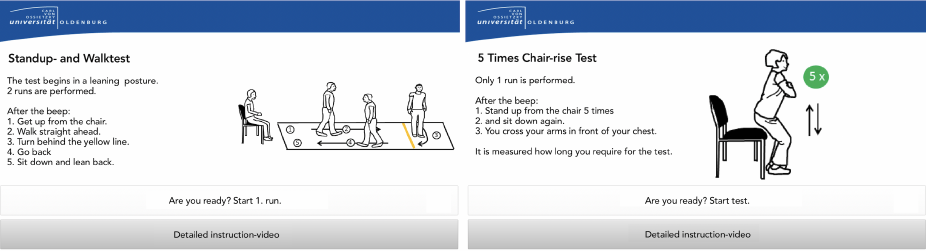
Figure 6. Examples for the instructional screens for the TUG and the 5 CRT. As the prototype has been only evaluated and implemented with German native speakers, the screens have been translated into English for this